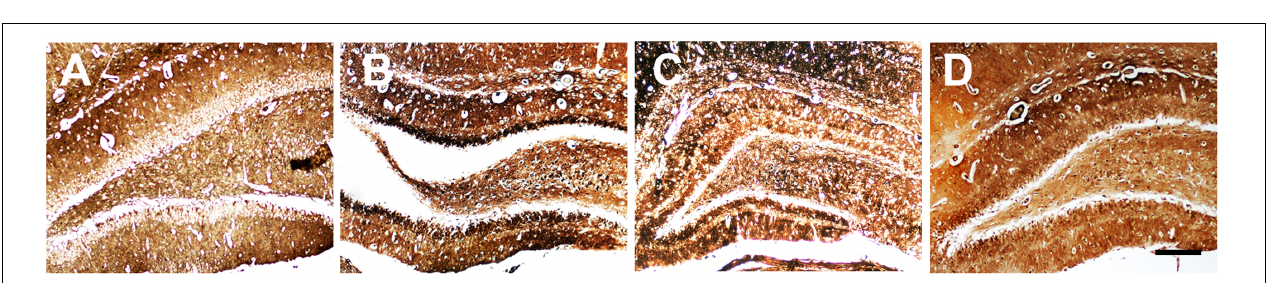
FIGURE 1 | Effects of Ant-134 on spatial learning memory formation. (A) miR-134 expression was upregulated in the hippocampus of SE rats. (B) Tracings of typical swim patterns and (C) proportion of time spent in target quadrant during the probe trail. The small circle in the third quadrant indicates the position of the escape platform. Data are expressed as mean ± SD, n = 6. ∗∗ p < 0.01, versus the control group, ## p < 0.01, versus the SE group.